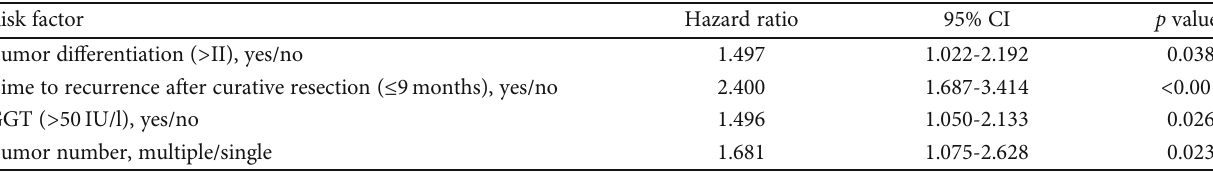
Table 3: Multivariate analysis of the factors associated with RFS of recurrent HCC patients undergoing